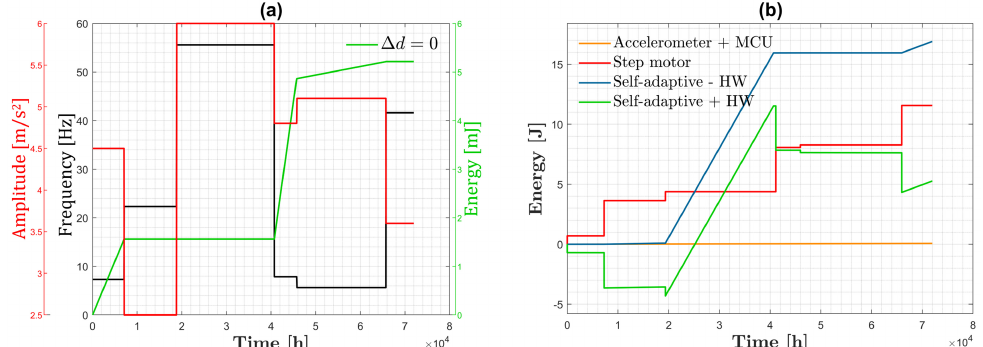
Figure 9. ( a ) Six random frequency and amplitude patterns under RTC on the left y-axis and correspondent harvested energy on the right y-axis for non-adaptive harvester; ( b ) energy demand from sensing, processing and actuation systems—self-adaptive harvested energy neglecting the hardware consumption, as well as considering the hardware consumption. The accelerometer inactivation time was set to 10